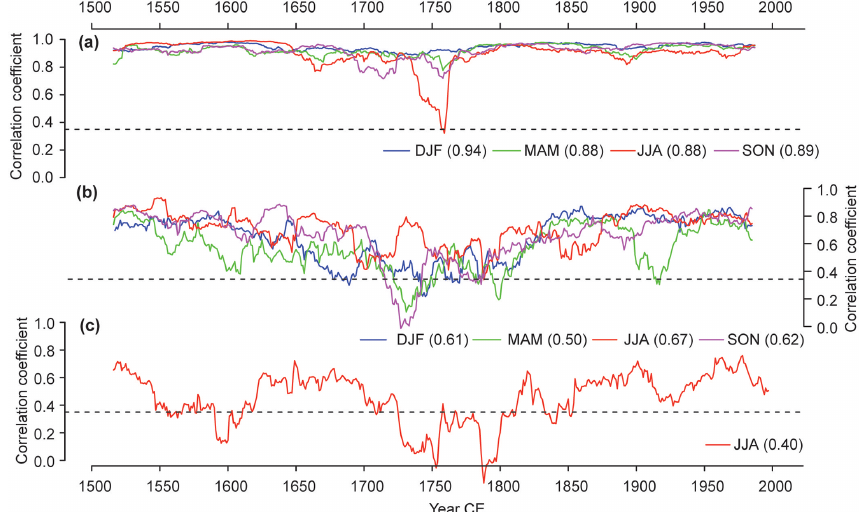
Figure 14. Running 31-year correlation coefficients between the seasonal Czech climate reconstructions and selected gridded reconstructions averaged over central Europe (45–54 ◦ N, 5–23 ◦ E): (a) central European temperatures (Dobrovolný et al., 2010) vs. temperatures according to Luterbacher et al. (2004) and Xoplaki et al. (2005) for the 1501–2002 period; (b) Czech precipitation (Dobrovolný et al., 2015) vs. precipitation totals according to Pauling et al. (2006) for the 1501–2000 period; (c) Czech JJA scPDSI (Brázdil et al., 2016) vs. JJA scPDSI according to Cook et al. (2015) for the 1501–2012 period. Numbers in brackets represent overall correlation coefficients for the entire common period in